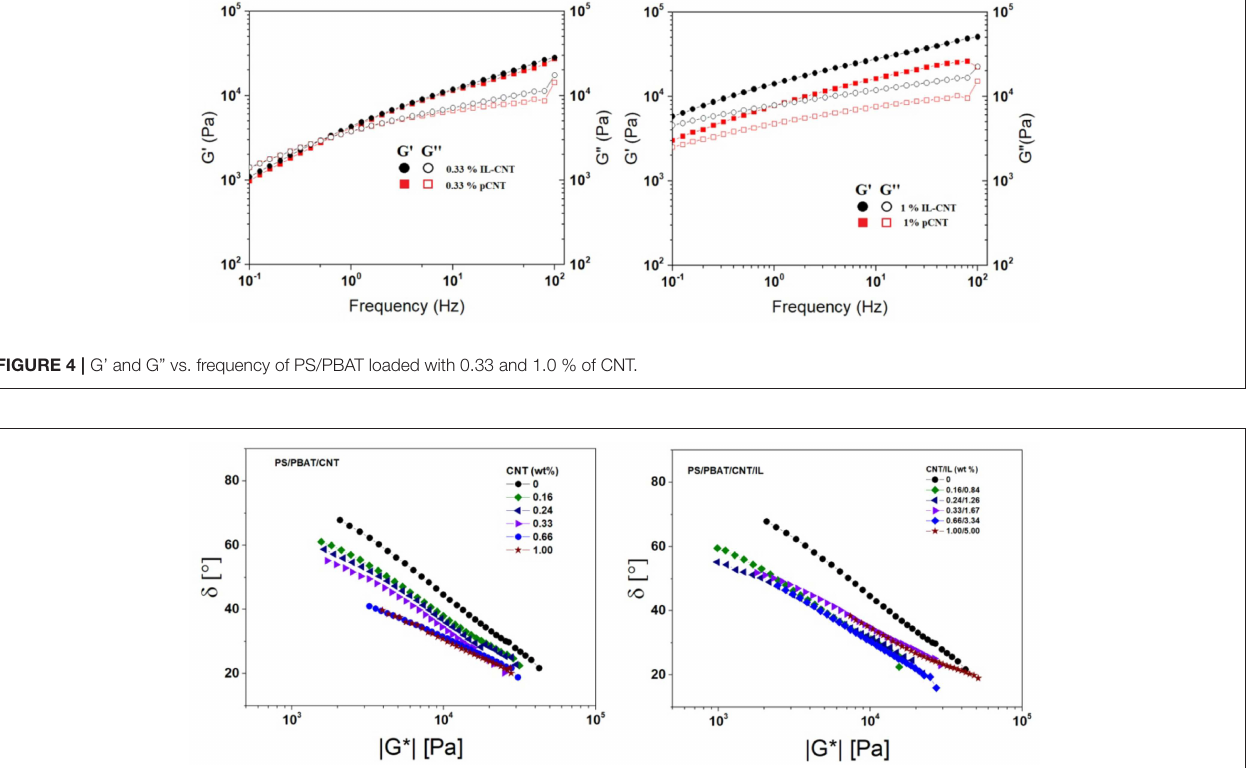
FIGURE 5 | Van Gurp-Palmen plot for the PS/PBAT composites as a function of the filler content Morphology.